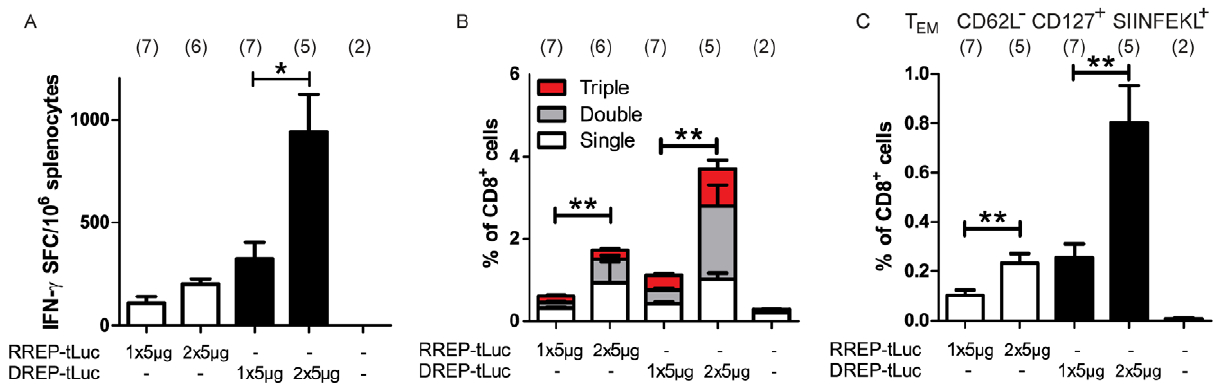
Figure 3. Cellular immune response 5 weeks post immunization. (a) Antigen-specific IFN- c positive CD8 + T cells per million splenocytes, (b) Proportion responding CD8 + T cells as determined by intracellular staining of IFN- c , IL-2 and TNF after SIINFEKL-peptide stimulation, or (c) proportion effector memory CD8 + T cells (pentamer H-2Kb/SIINFEKL positive CD8 + CD62L 2 CD127 + cells) 5 weeks after the last intradermal immunization in combination with electroporation. Mice were either given one immunization (1 6 5 m g) or two immunizations 5 weeks apart (2 6 5 m g). Data shows average number of positive cells with error bars showing standard error of the mean. A booster immunization significantly increased the cellular memory response for both RREP-tLuc and DREP-tLuc (p , 0.01). The total number of mice per group is indicated in parenthesis above each bar.